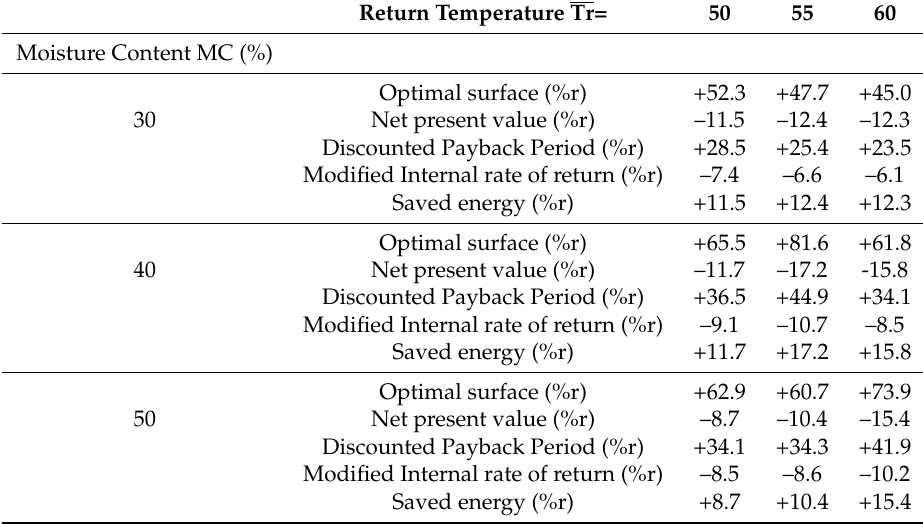
Table 6. A comparison between the optimal design in terms of energy savings and the most economical design. The FGC surfaces, NPVs, and energy savings obtained for the optimal energy savings are compared to those obtained in the most economical cases. All values are expressed as relative percentage